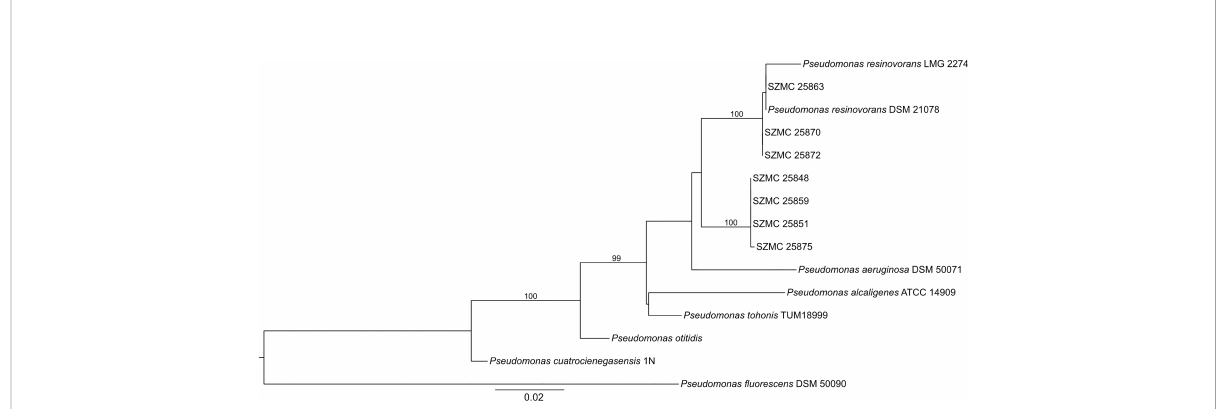
FIGURE 1 Maximum Likelihood phylogenetic tree of P. resinovorans isolates. Statistical support of the best tree was calculated with Ultrafast bootstrap approximation with 5000 replicates. Only bootstrap values above 95% - providing reliable results - are